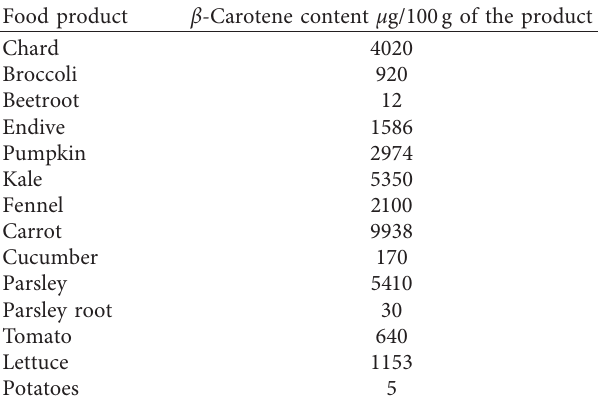
Table 4: β -Carotene content of selected vegetables [39]. Food product